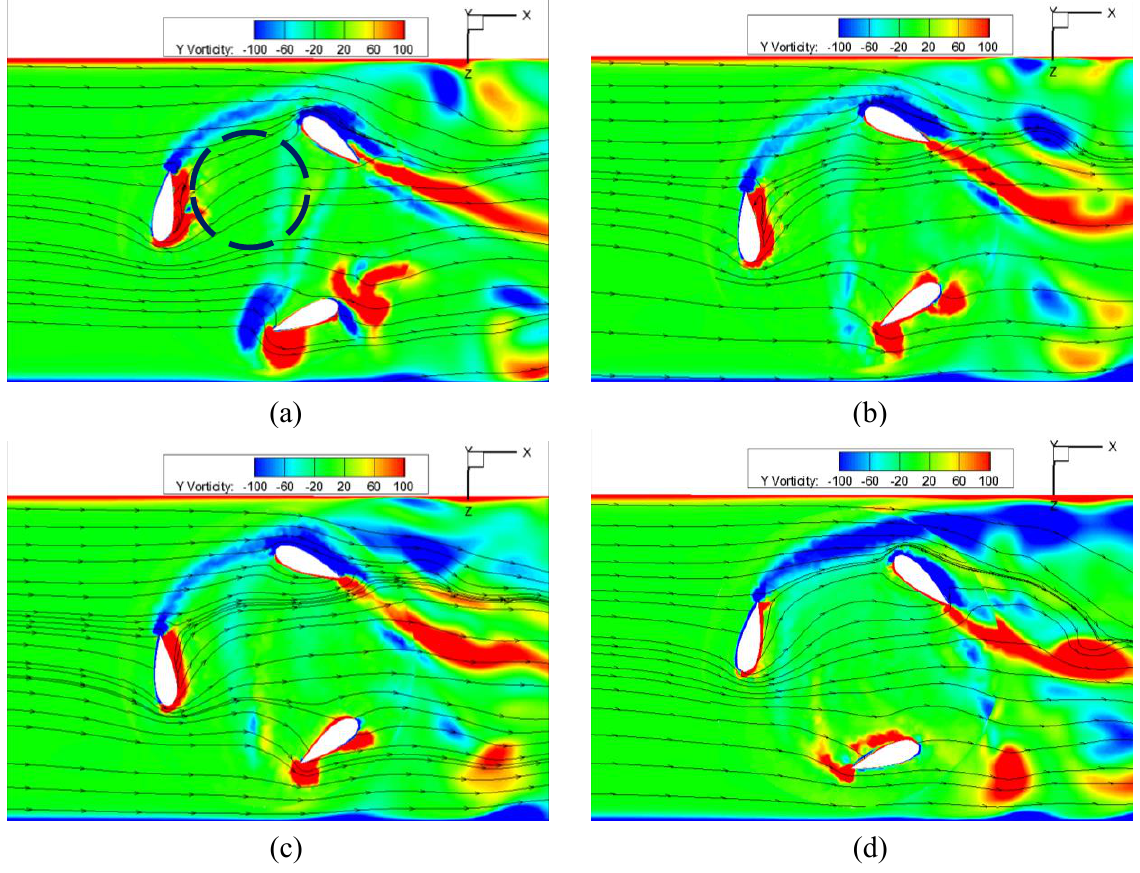
Figure 14. Y-vorticity contours and streamlines on y = 0.1D_turbine at ( a ) TSR = 1.41, ( b ) TSR = 2.00, ( c ) = TSR = 2.40 and ( d ) TSR = 3.51.